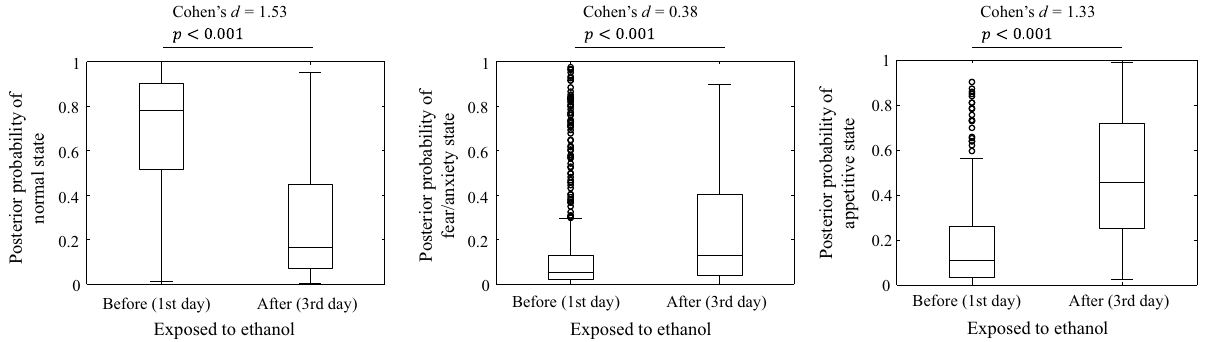
Figure 11. Posterior probability obtained from LLGMN in the ethanol-induced place preference experiment. The plots compare the posterior probabilities of each emotional state between before and after conditioning using ethanol in the 2nd day of the